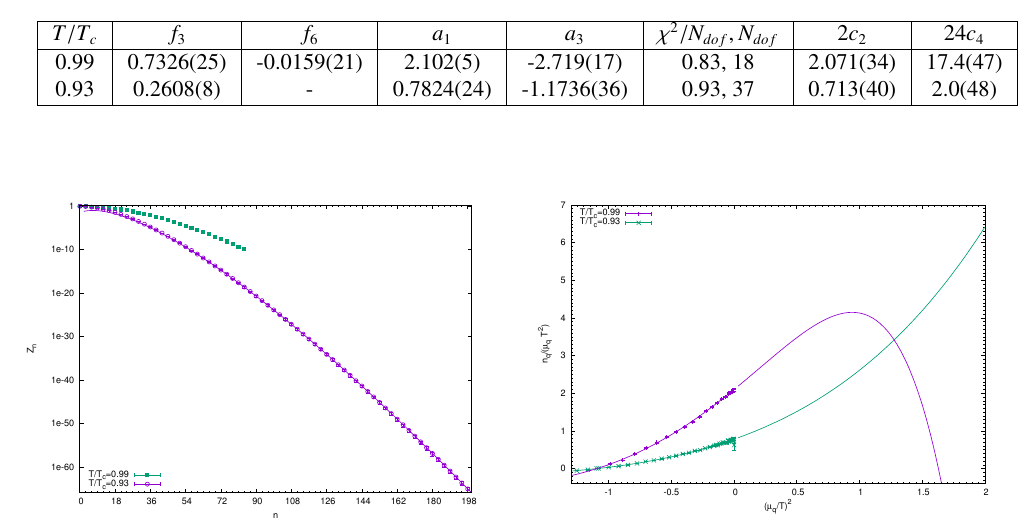
Figure 3. Z n vs n for T / T c = 0 . 93 and 0.99. The curve shows results of fitting to asymptotic behaviour (22) for T / T c = 0 . 93.